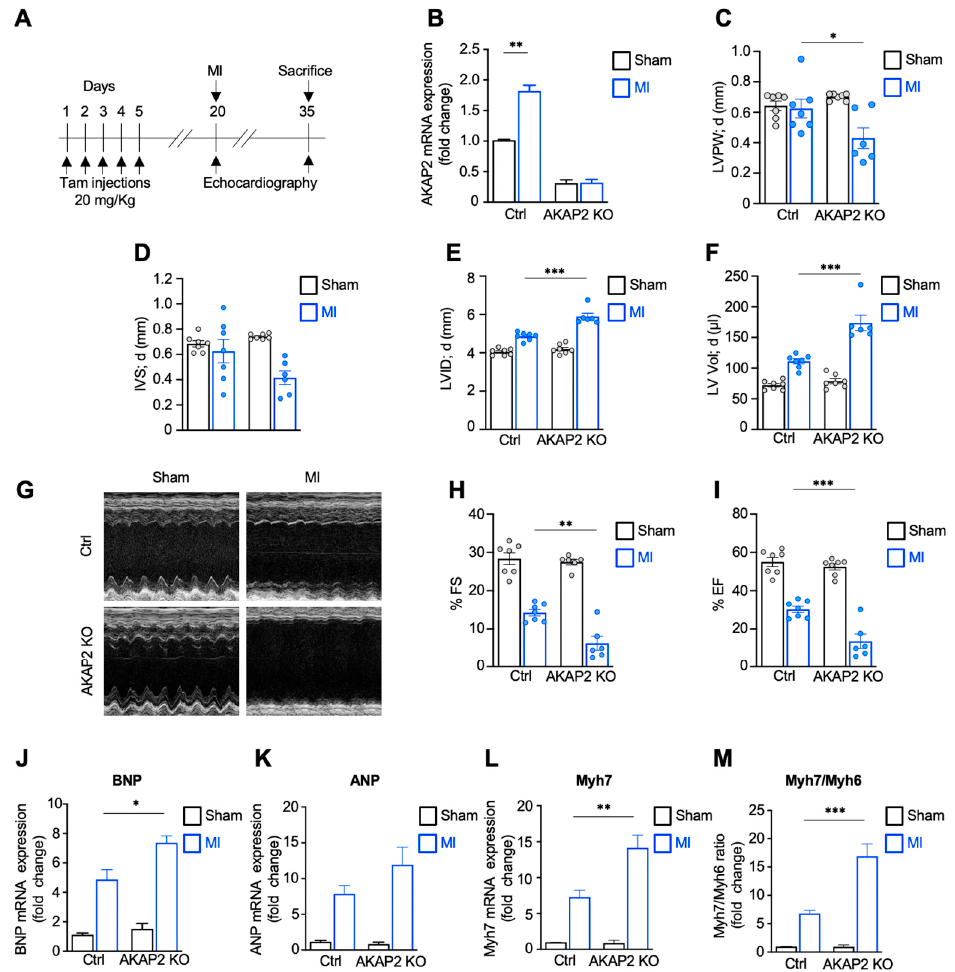
Figure 2. Targeted deletion of AKAP2 in adult cardiomyocytes exacerbates MI-induced cardiac stress and dysfunction. ( A ) Timeline of MI experimental protocol. MI was induced by LAD ligation 15 days after tamoxifen injections. Echocardiography was performed prior and 15 days after surgery. ( B ) AKAP2 mRNA expression in heart lysates from control (Ctrl) and AKAP2 KO male mice subjected to sham surgery or MI was assessed by quantitative real-time PCR. Ctrl-sham n = 4, Ctrl-MI n = 3, AKAP2 KO-sham n = 4, AKAP2 KO-MI n = 4. ( C ) End-diastolic (LVPW;d) left ventricular posterior wall thickness. ( D ) End-diastolic (IVS; d) intraventricular septum thickness. ( E ) End-diastolic (LVID; d) left ventricular internal diameter. ( F ) End-diastolic (LV Vol; d) left ventricular volume. ( G ) Transthoracic M-mode echocardiography tracings. ( H , I ) Fractional shortening (FS) and Ejection fraction (EF). Size of the experimental groups size for panels ( C – J ): Ctrl-sham n = 7, Ctrl-MI n = 7, AKAP2 KO-sham n = 7, AKAP2 KO-MI n = 6. ( J – M ) Quantitative real time PCR analysis of the expression of BNP ( J ), ANP ( K ), Myh7 ( L ). The Myh7: Myh6 ratio is shown (M) . Ctrl-sham n = 4, Ctrl-MI n = 4, AKAP2 KO-sham n = 4,